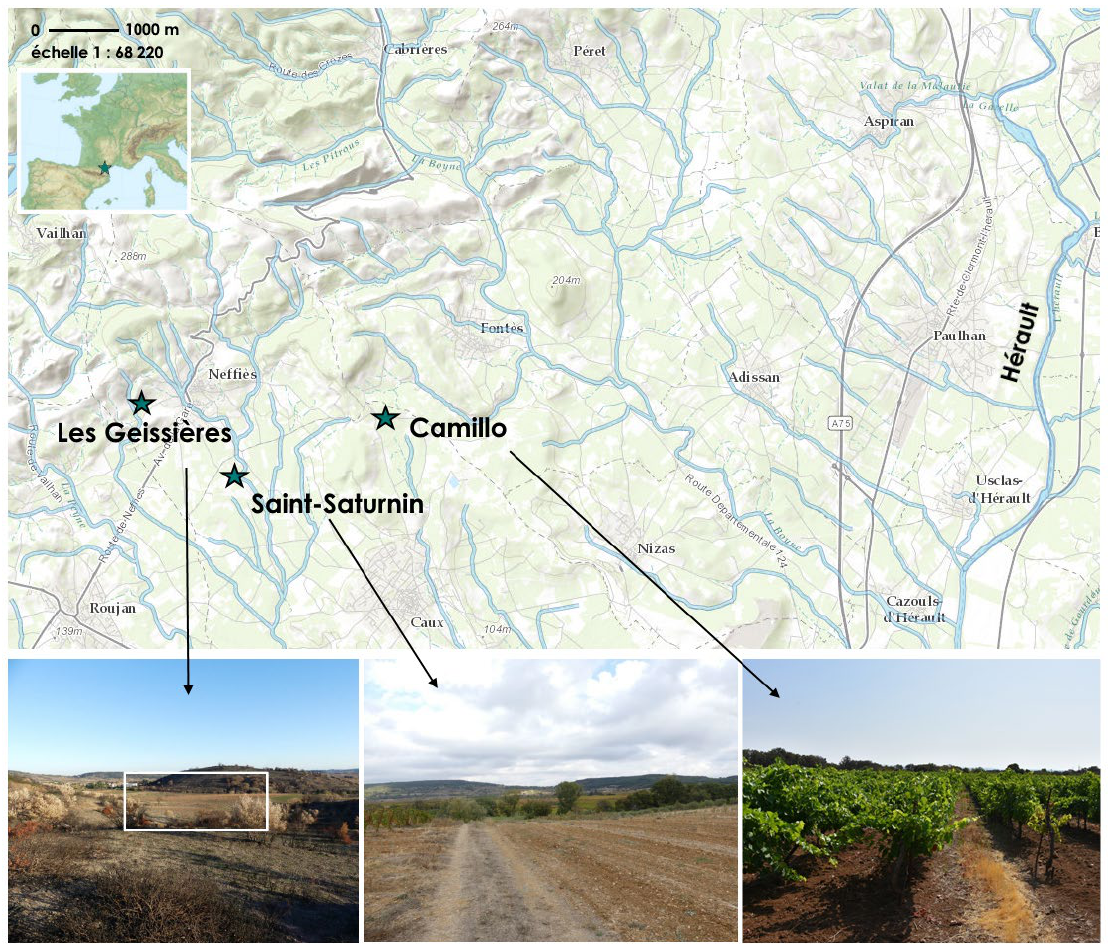
Figure 3. Geographical location and general views of the surface stations of Les Geissières, Saint-Saturnin and Camillo (Hérault,